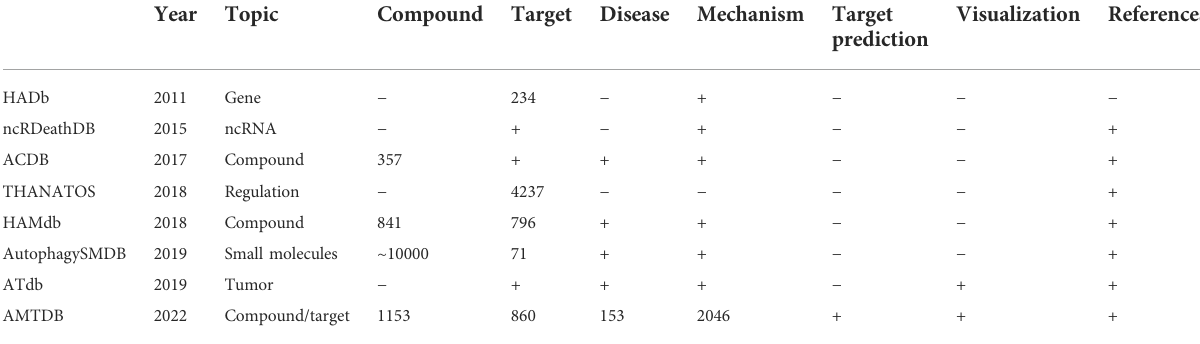
TABLE 2 Comparisons of autophagy-related